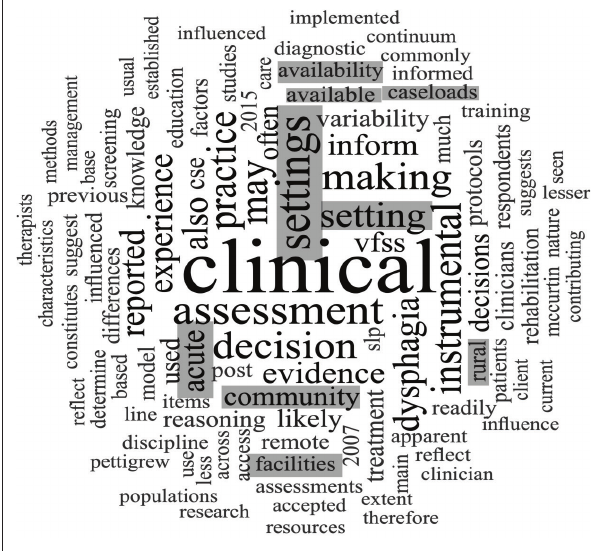
FIGURE 3: Word cloud of clinical setting, generated in NVivo